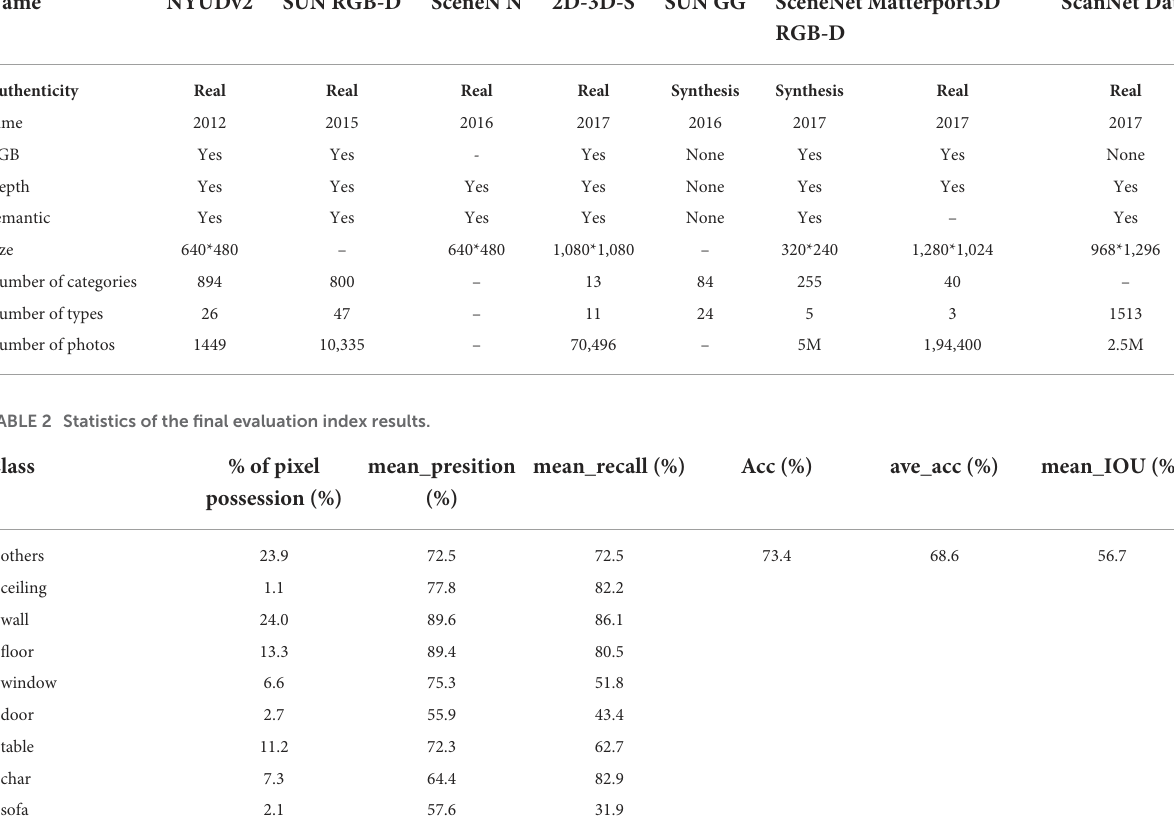
TABLE 1 Statistical results of publicly available datasets.